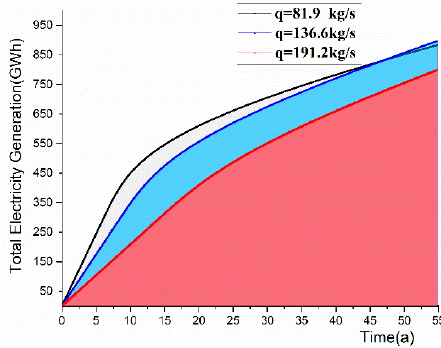
Figure 20. Predicted total electricity generation ( W c ) of three EGS cases with different injection rates.